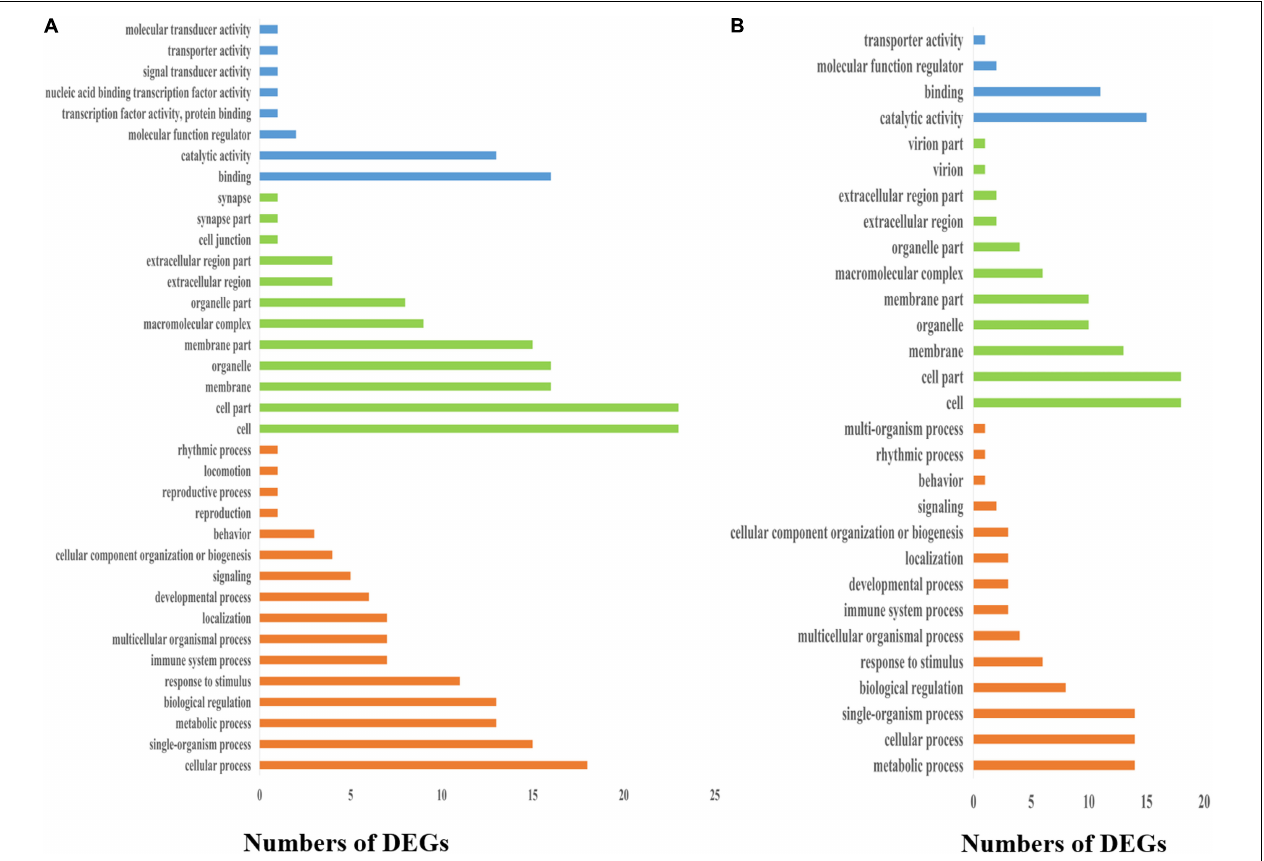
FIGURE 4 | Distribution of GO classifications of DEGs in bone tissues of bighead carp. (A) Distribution of GO classifications of DEGs in the frontal and parietal bones. (B) Distribution of GO classifications of DEGs in the vertebral bones. Blue, green, and orange colors represented molecular function, cellular component, and biological process categories,